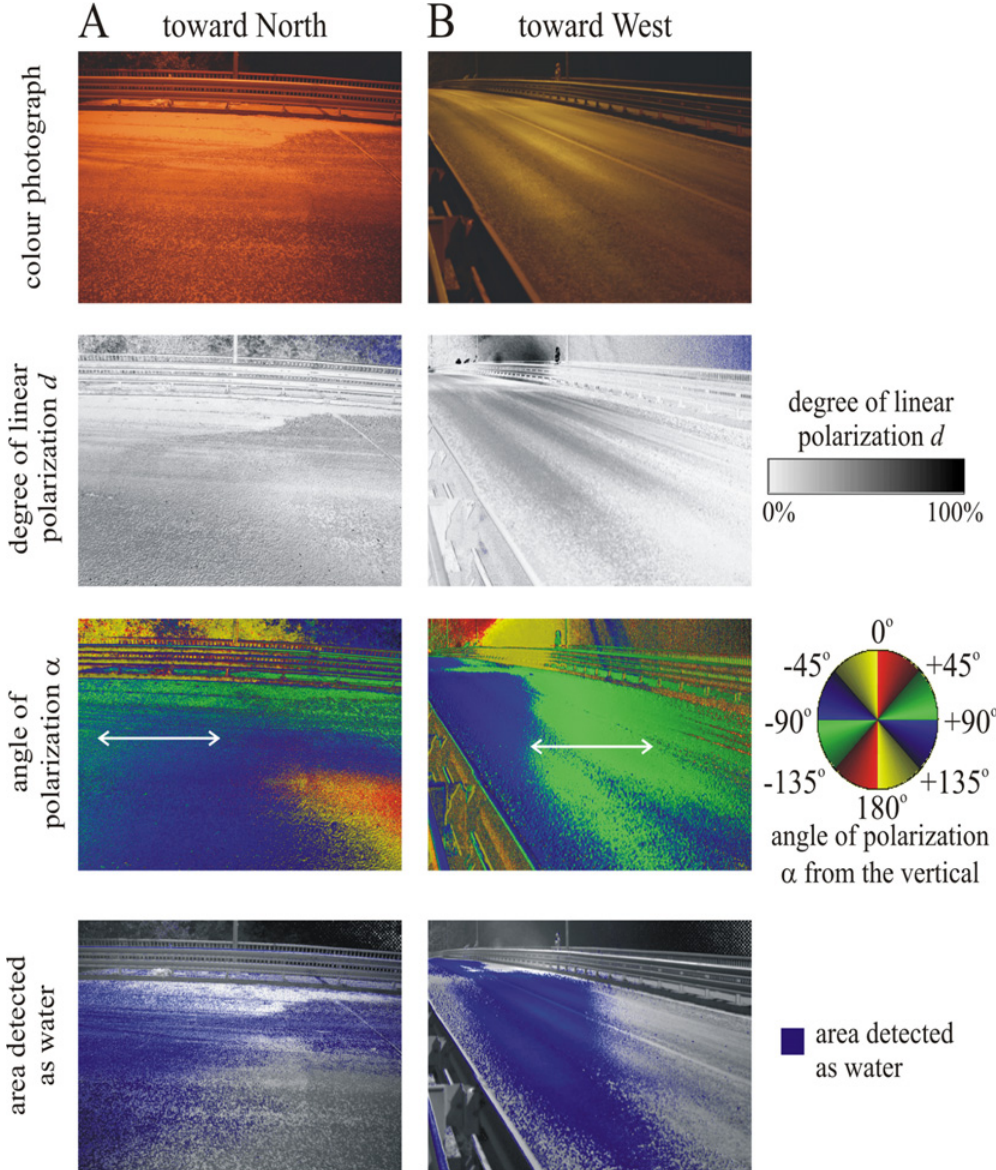
Fig 3. (A, B) Color photograph, patterns of the degree d and angle α (clockwise from the vertical) of linear polarization, and areas detected polarotactically as water (for which d > 15% and 80° < α < 100°) of the dry asphalt road on the bridge (above the river Danube at Tahitótfalu) illuminated by bridge-lamps at night during the mass congregation of Ephoron virgo mayflies. The patterns were measured by imaging polarimetry in the blue (450 nm) part of the spectrum from two different directions of view, when the optical axis of the polarimeter pointed toward North (A) and West (B). The angle of elevation of the optical axis of the polarimeter was 20° from the horizontal. In the α -pattern the local direction of polarization of asphalt-reflected light is shown by a double-headed arrow. The white spot composed of millions of Ephoron virgo carcasses on the asphalt road below the bridge-lamp is well visible on the photographs as well as in the patterns of the degree of polarization d and the area detected as